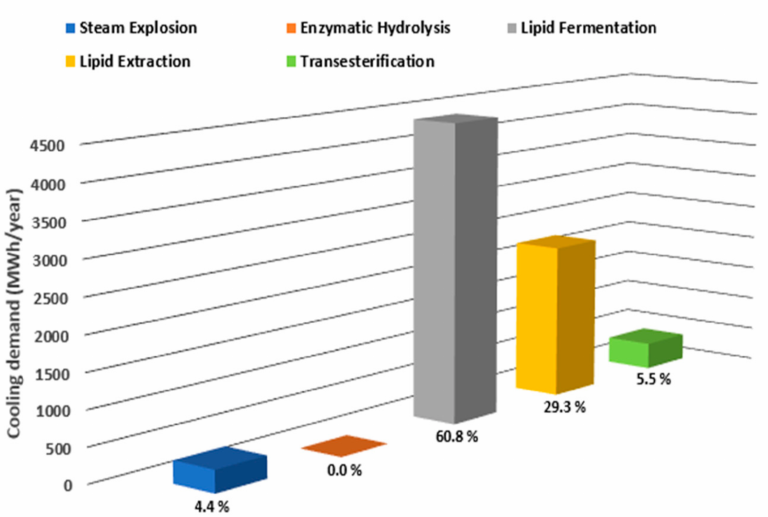
Figure 8. Distribution of removed heat expressed in MWh/y and considering an operating period of 8000 h/y.